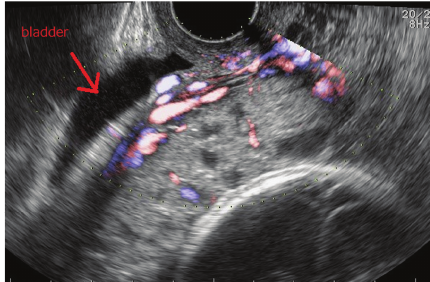
Figure 2: At 24 weeks of gestation. Transvaginal ultrasonography revealed loss of hypoechoic appearance of the retroplacental zone, lacunas in the placenta, and bulging of the bladder.